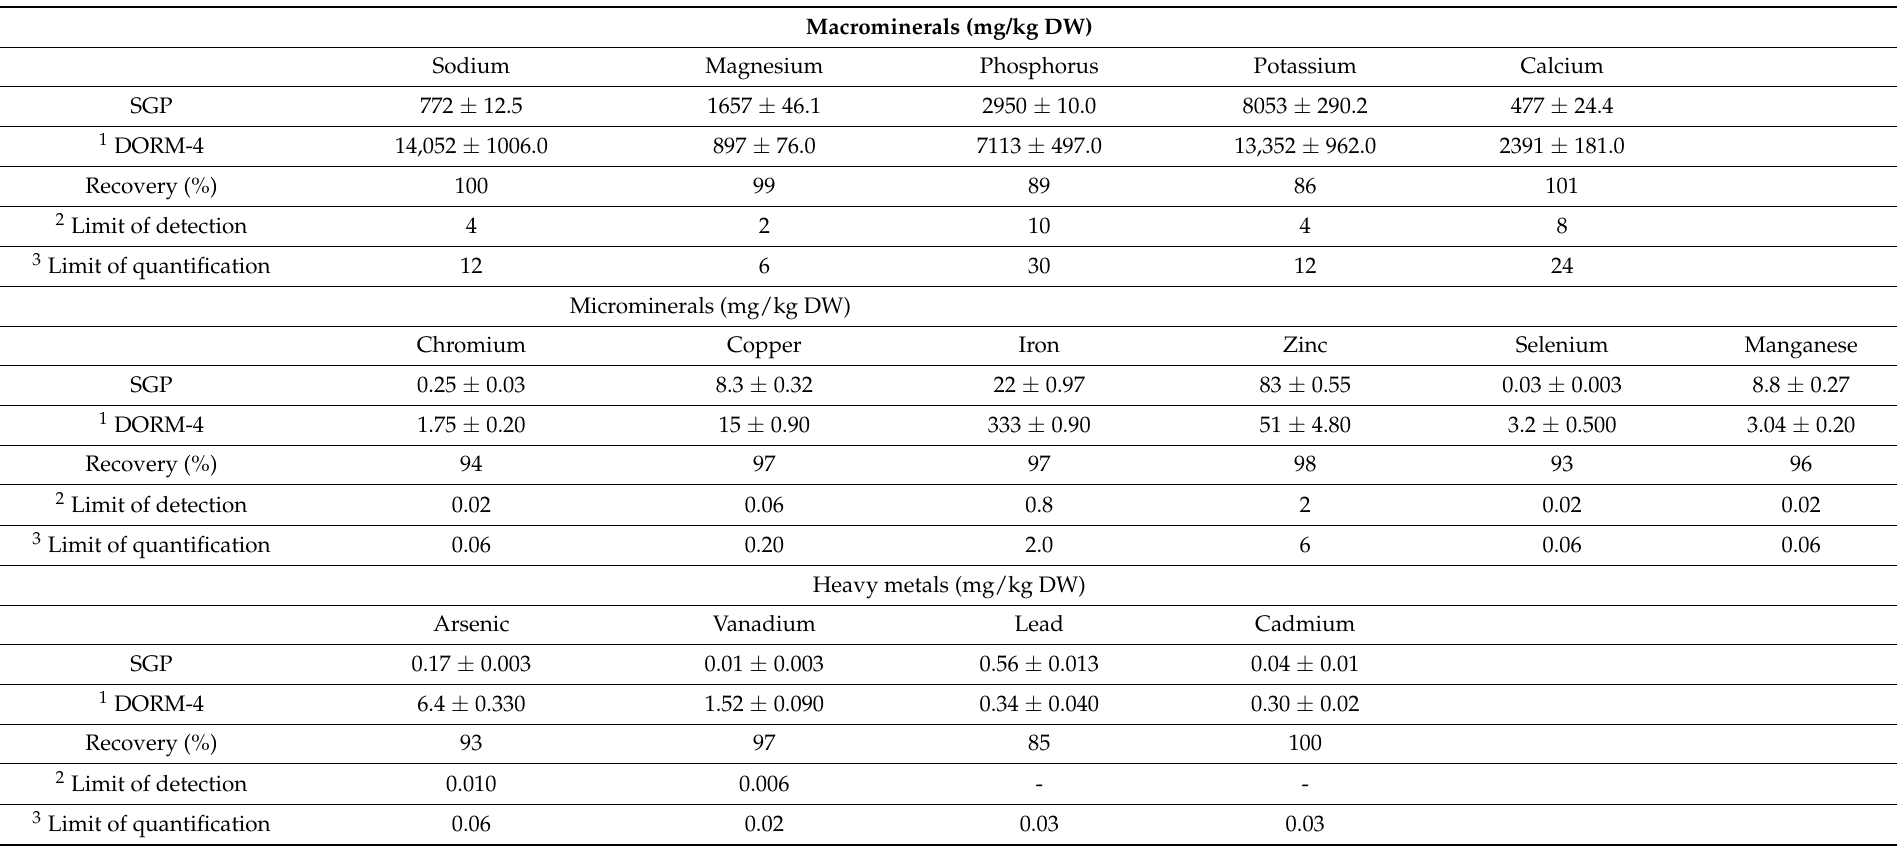
Table 2. Mineral content of SGP of macrominerals, micro/trace minerals, and heavy metals expressed in mg/kg,